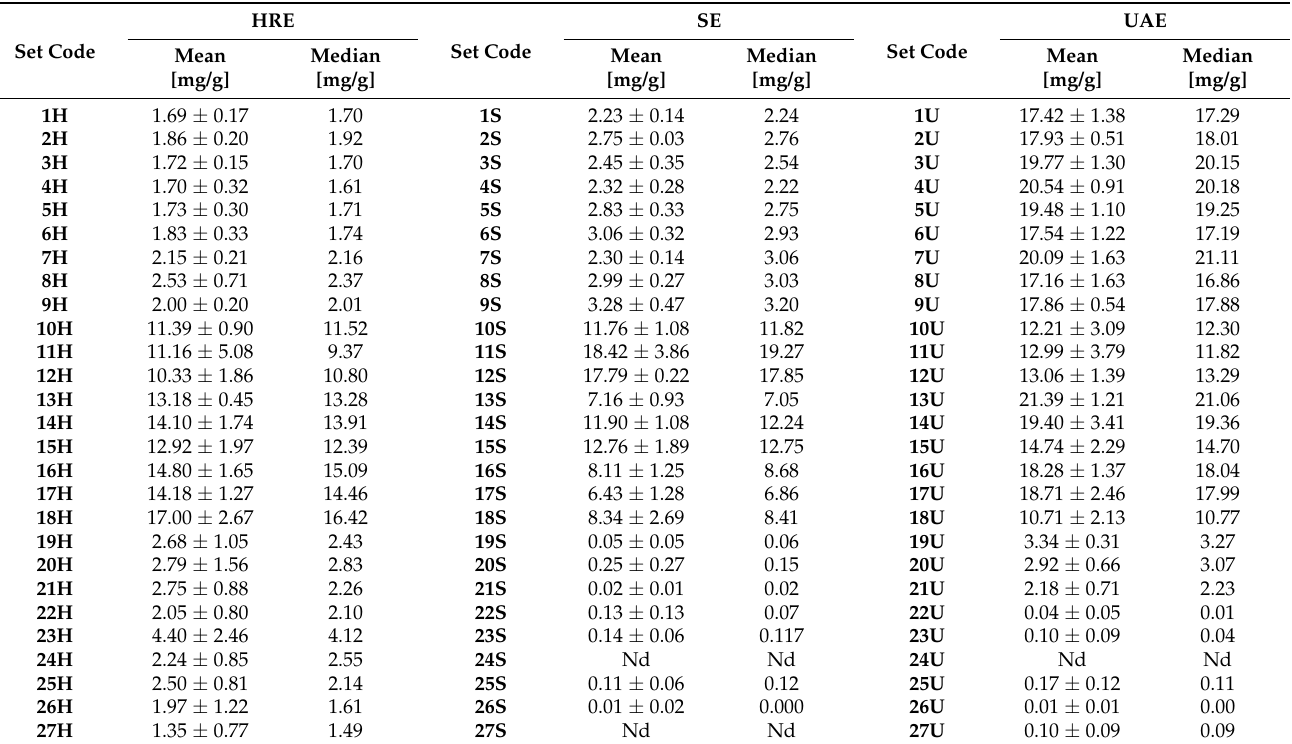
Table 2. The means ( ± standard deviation, SD) and medians of rapanone content in the extracts obtained in various experimental systems, calculated as milligrams of rapanone per 1 g of dried weight of plant